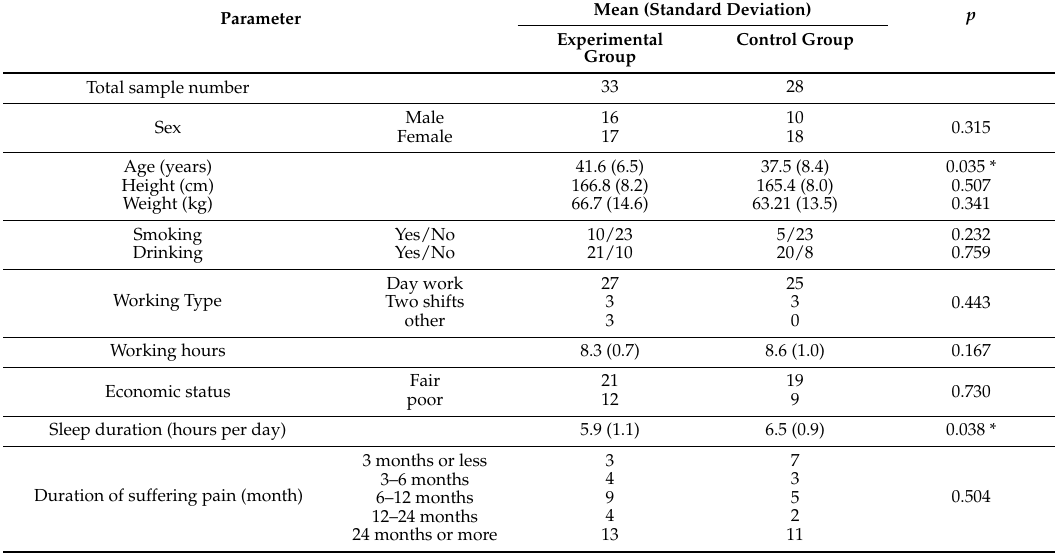
Table 1. Demographic characteristics and pain measurements in an experimental and control